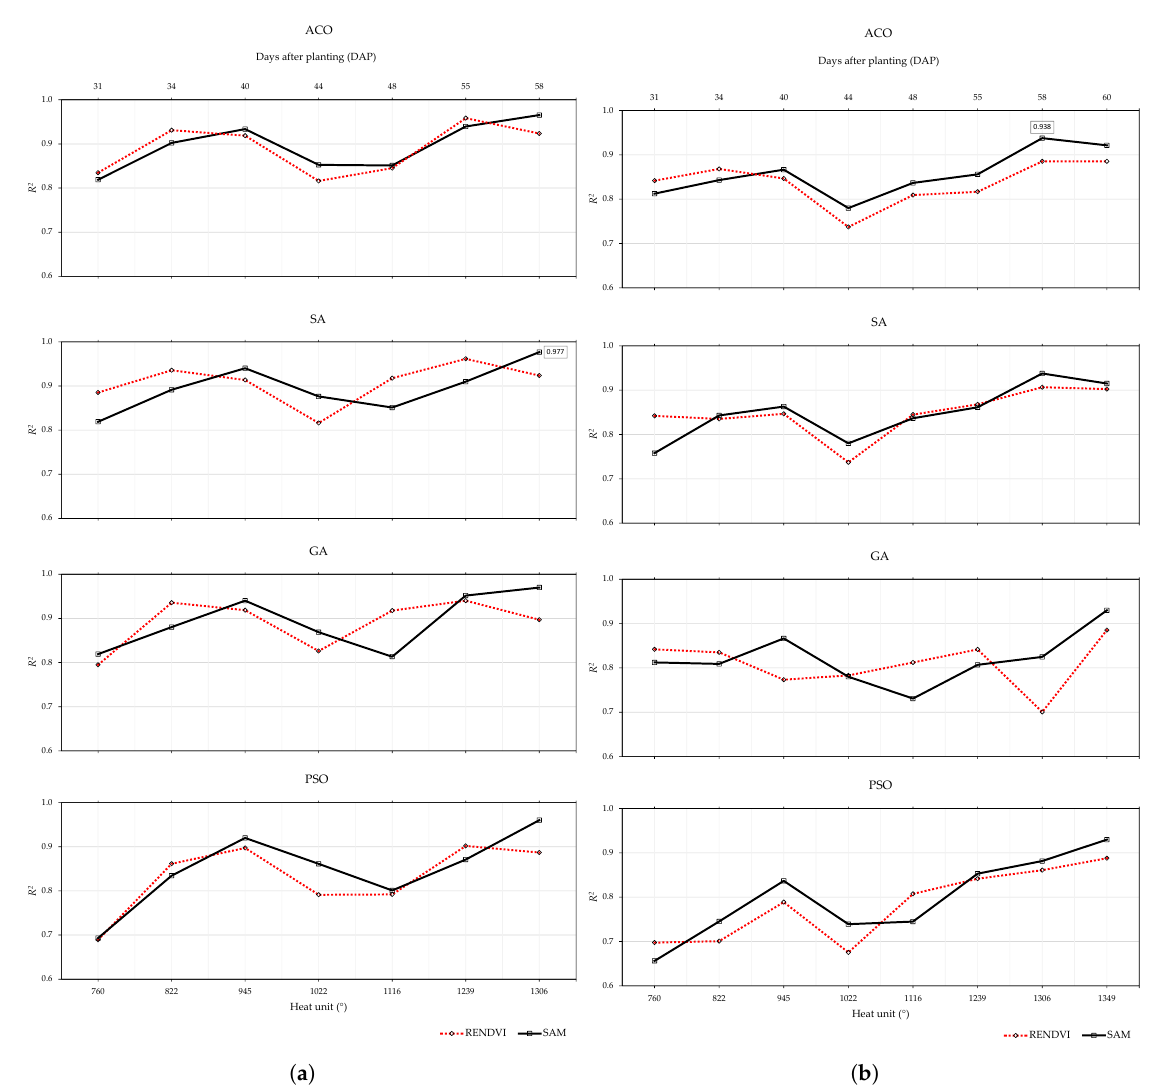
Figure 18. Coefficient or determination metric for snap bean 2020 seed length data set, for ( a ) early and ( b ) the late harvest stage via two SAM and RENDVI, tested with